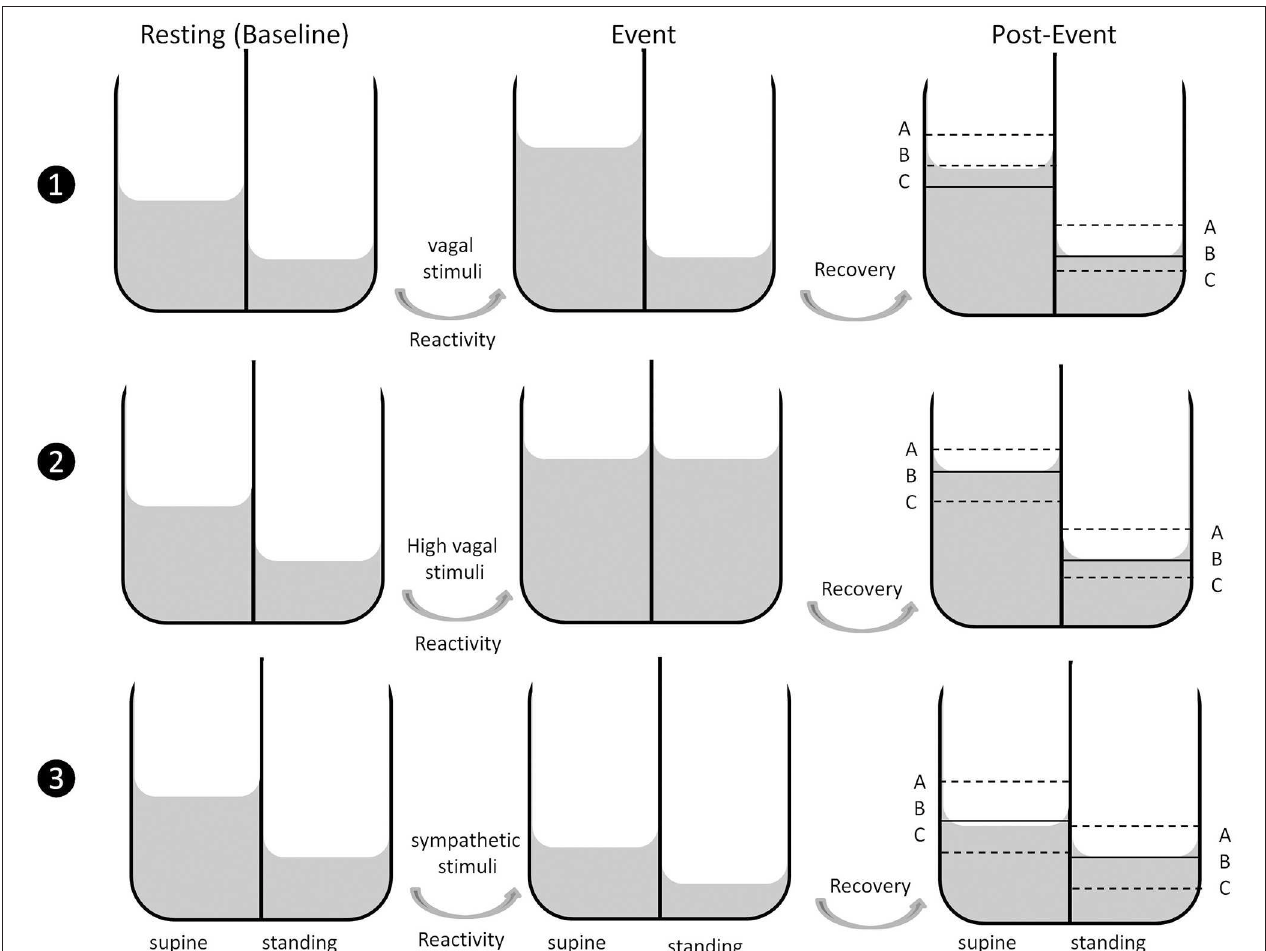
FIGURE 1 | Adjusted vagal tank model according to Laborde et al. (2018) for application in sports including the orthostatic test. Vagal tank with vagal stimuli (1), with high vagal stimuli (2), and sympathetic stimuli (3). In regards to the post-event: A, B, and C display potential levels of cardiac vagal control at post-event after